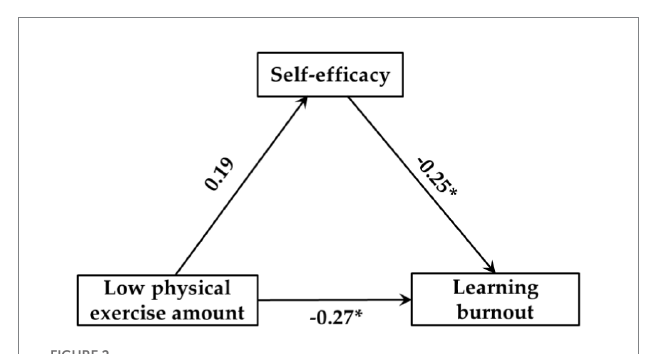
FIGURE 2 Mediating model of self-efficacy between low exercise amount and learning burnout.